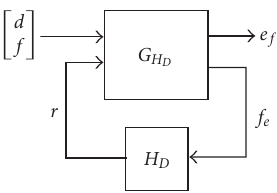
Figure 3: LFT formulation for detection filter H D